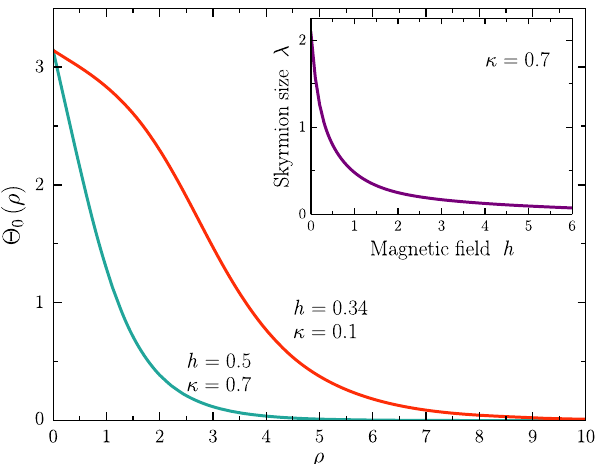
FIG. 2. Magnetization profiles Θ 0 ð ρ Þ of a Skyrmion as function of radial distance ρ for a small-radius Skyrmion with chosen easy-axis anisotropy κ ¼ 0 . 7 and magnetic field h ¼ 0 . 5 (green line) and a large-radius Skyrmion with κ ¼ 0 . 1 and h ¼ 0 . 34 (red line). Magnetic field is applied along the easy axis (all parameters given in scaled dimensionless units; see text). The inset depicts the dependence of the Skyrmion radius λ on h for κ ¼ 0 .